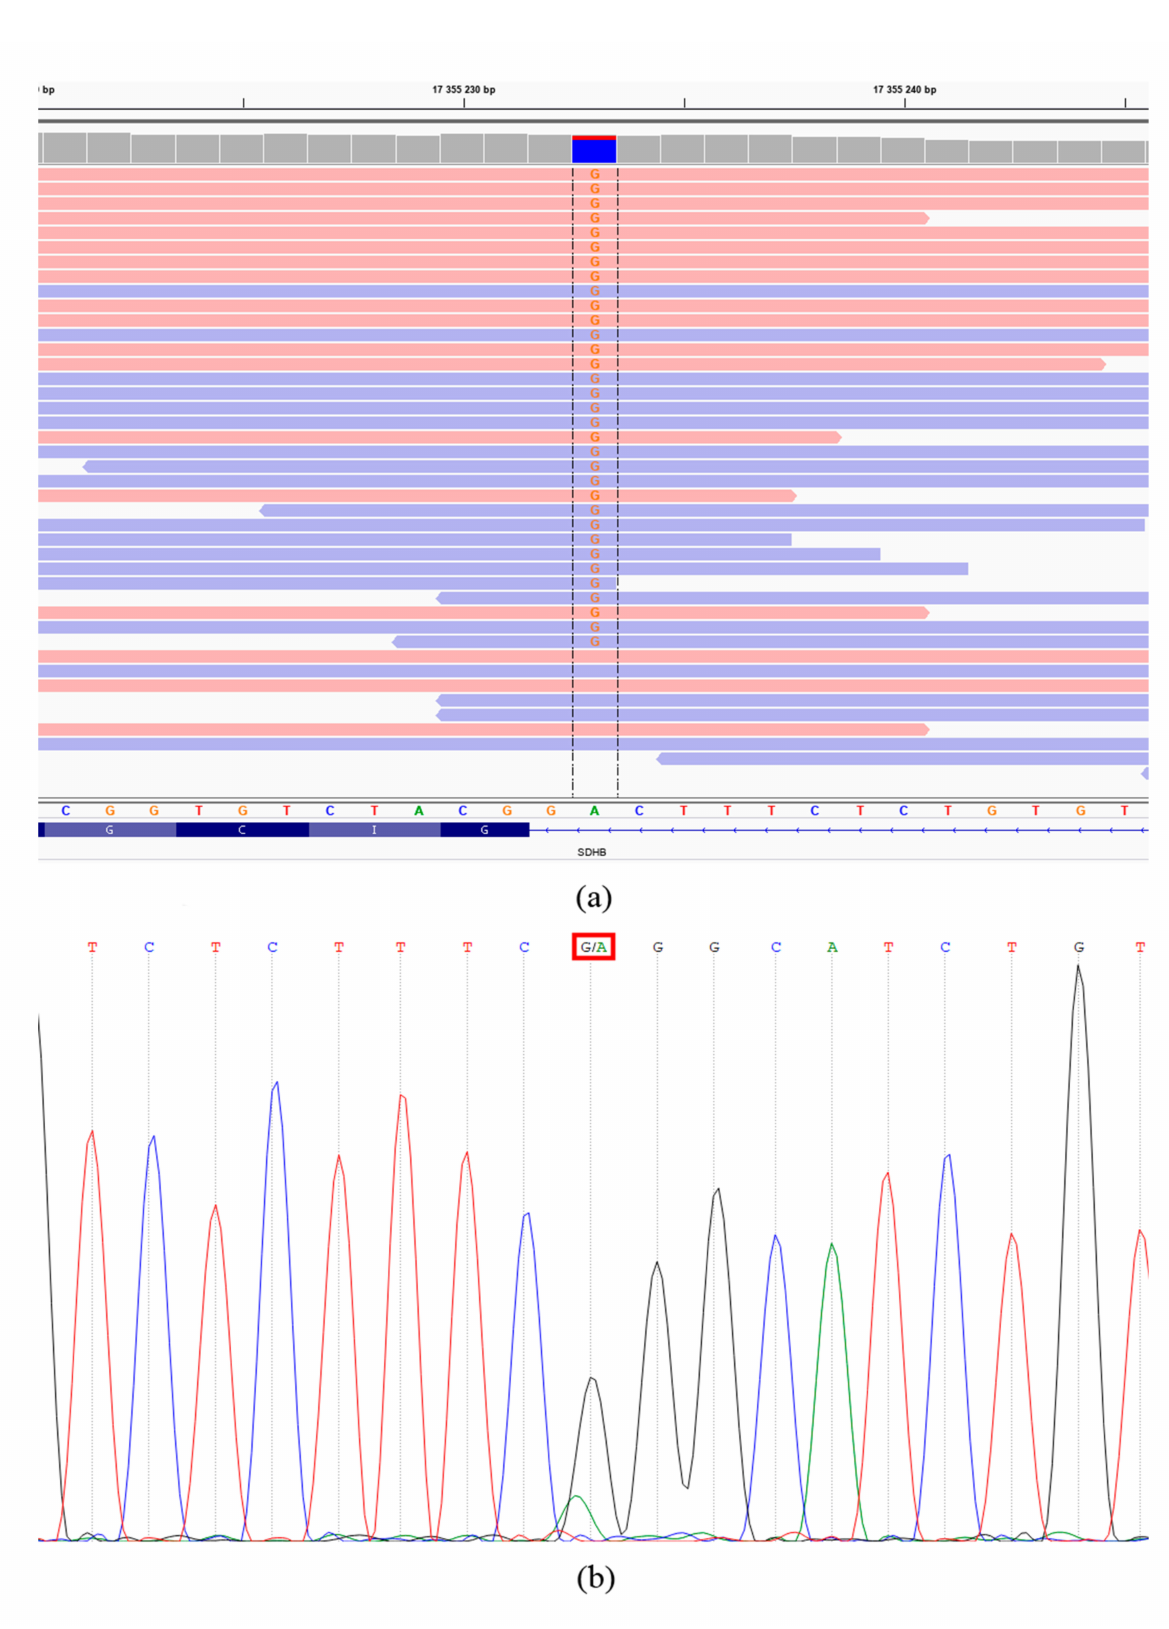
Figure 3. Validation of the SDHB c.287-2A>G mutation with Sanger sequencing in the recurrent tumor. ( a ) Exome sequencing data (variant nucleotides are marked by red color, forward and reverse reads present as pink and blue horizontal lines, respectively). ( b ) Sanger sequencing